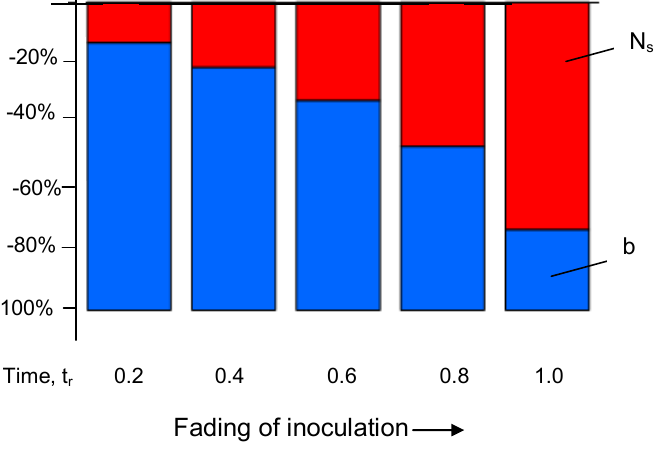
Figure 26. Intensity effect of t r on the CT index through N s and b (− CT